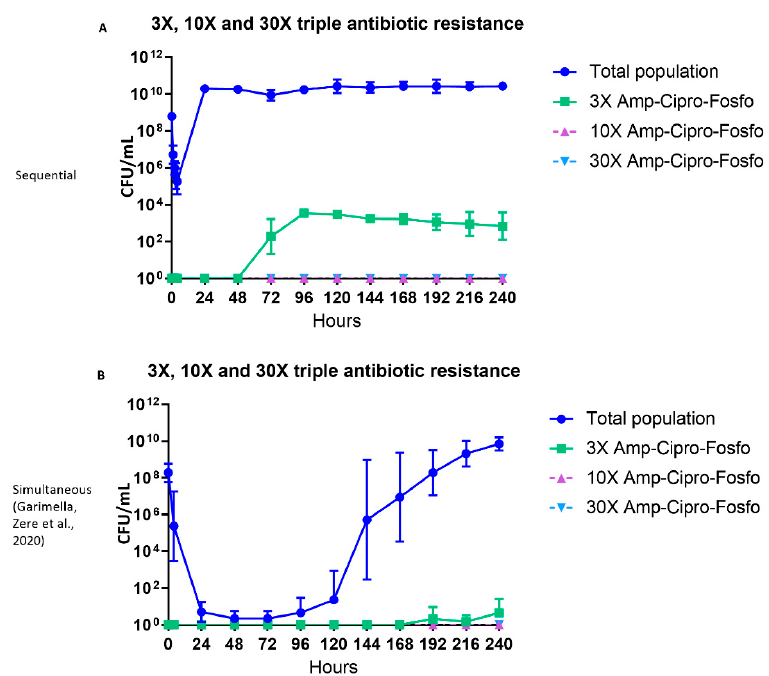
Figure 4. The effect of ampicillin, ciprofloxacin and fosfomycin sequential ( A ) and simultaneous combination ( B ) [23] therapy regimens on the density of the total and triple antibiotic-resistant subpopulations in the hollow fiber infection model over 10 days. The 3 × , 10 × and 30 × triple antibiotic-resistant subpopulations (Amp-Cipro-Fosfo) were grown on agar containing the respective combinations of antibiotic minimum inhibitory concentration (MIC) levels. Data are presented as the geometric mean of three (sequential regimen) and four (simultaneous combination regimen) independent hollow fiber runs, and the error bars represent the geometric standard deviation.